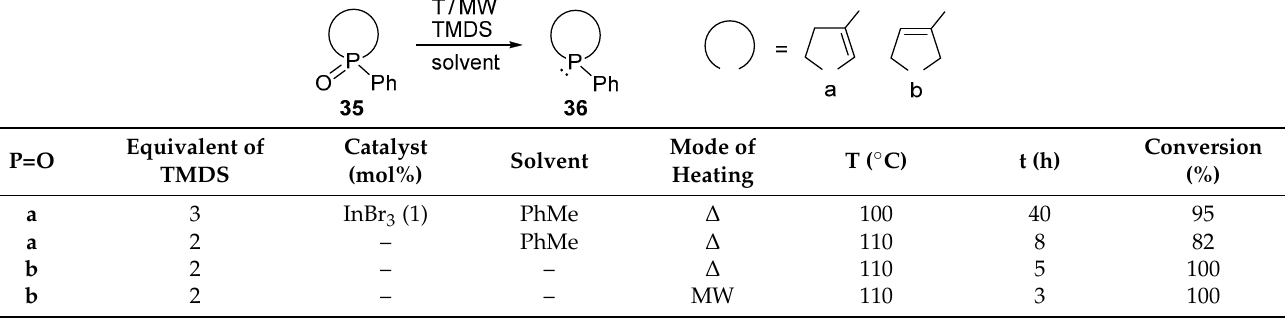
Table 12. Deoxygenation of phospholene oxides ( 35 ) applying TMDS.